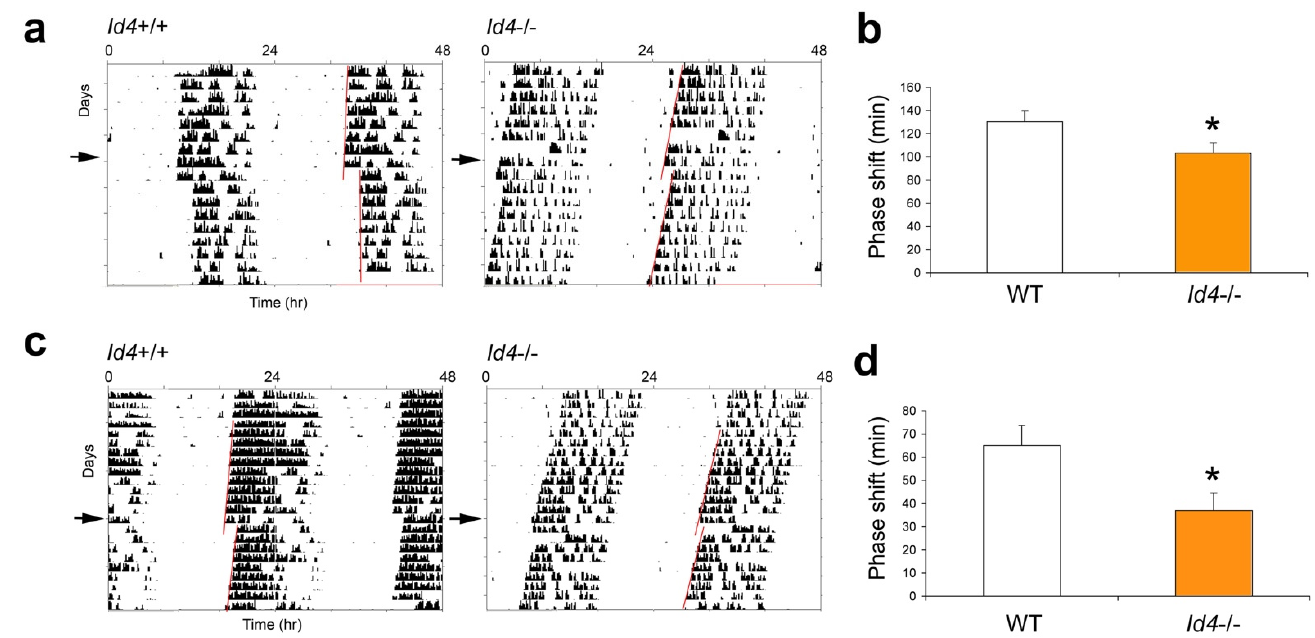
Figure 3. Id4 − / − mice treated with a single SATURATING (30 min, 1000 lux) or a SUB ‐ SATURATING (4 min, 8 lux) discrete light pulse at Circadian time 16 (CT16) exhibit a decrease in the magnitude of the phase shift. Wild ‐ type ( Id4 +/+, WT) and Id4 − / − mice ( n = 20 and 16, respectively) were maintained in DD, and wheel ‐ running activity was recorded. Mice were exposed to a saturating ( a ) or sub ‐ saturating light treatment ( c ). The arrow on the left indicates the actual day of treatment. A line is fitted to the phase of activity onset before and after the light treatment, and the time difference between the two lines is the measured phase delay of the free ‐ running rhythm. Mean ± standard error of the mean (SEM) magnitude of the phase shifts in wild ‐ type (white) and Id4 − / − mice (orange) produced by the ( b ) saturating and ( d ) sub ‐ saturating light treatment (* p < 0.05).